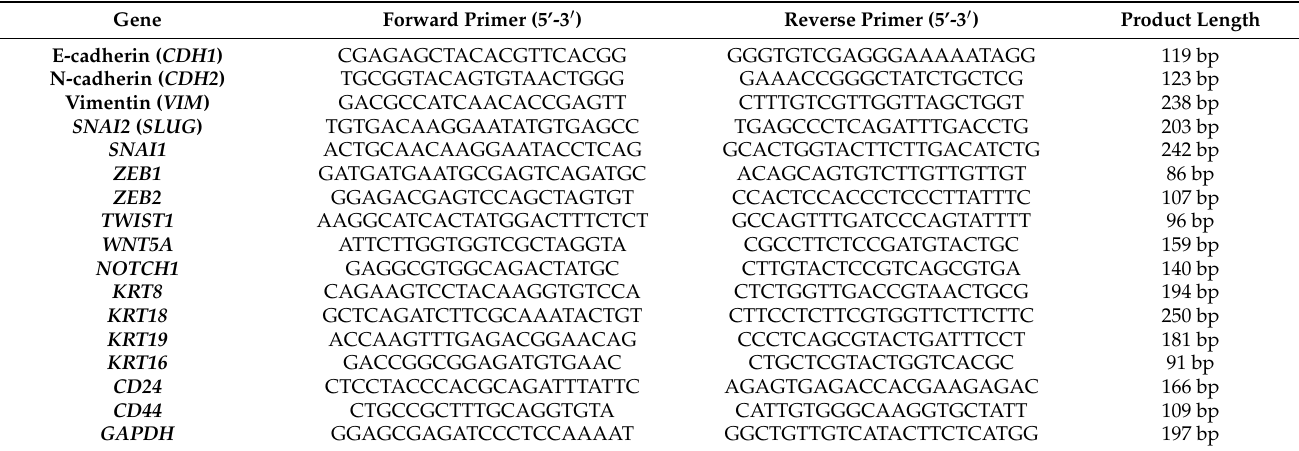
Table 1. Specific primers used in